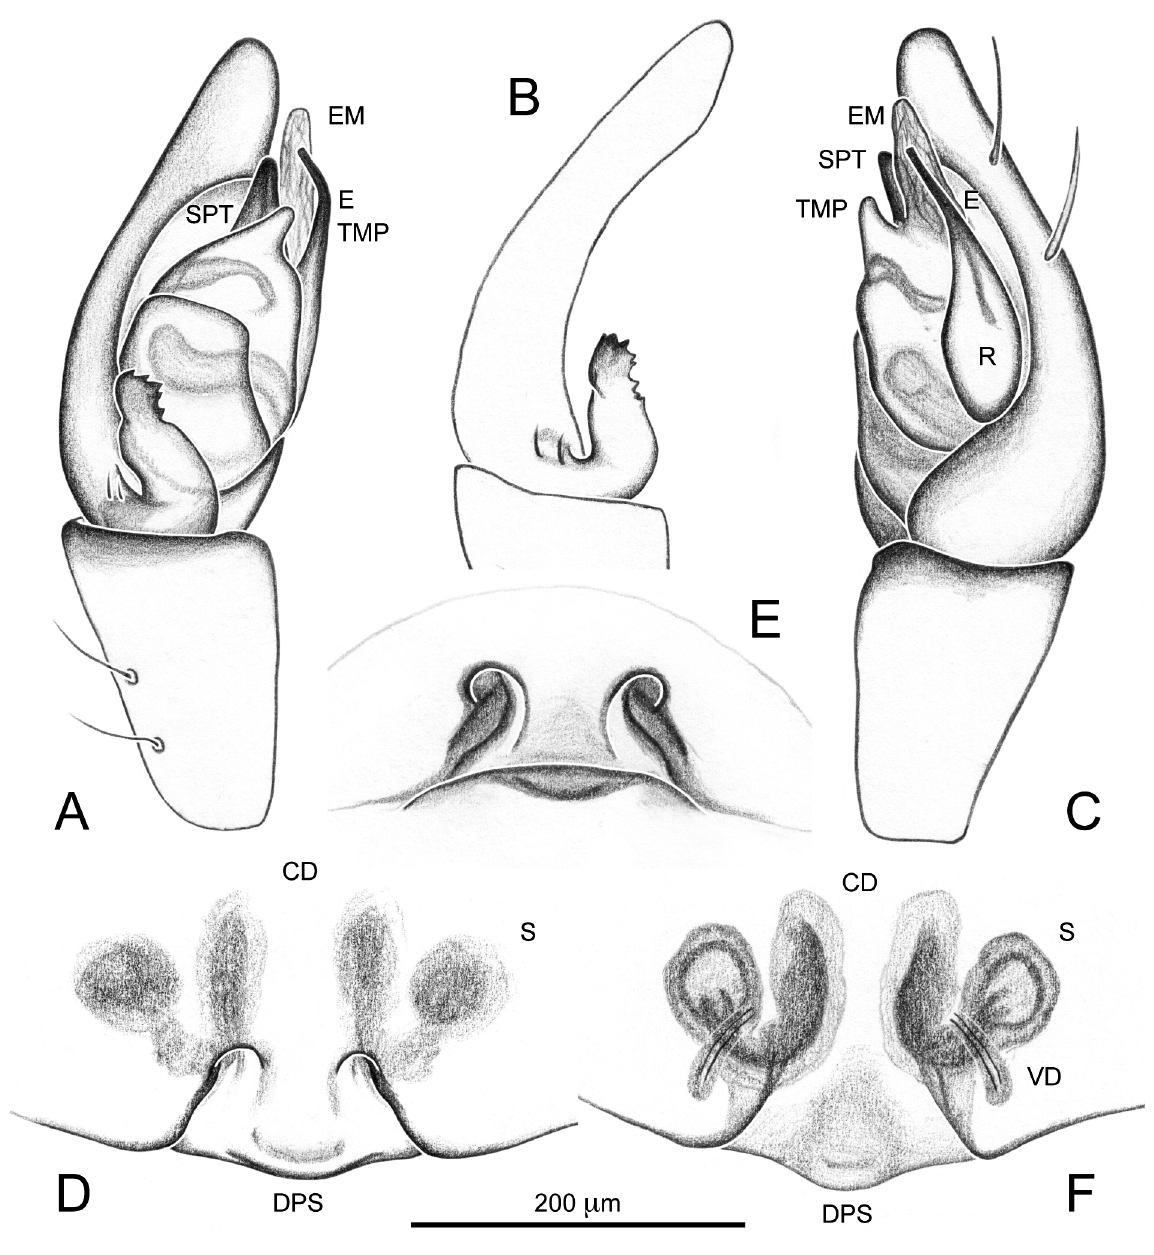
Fig. 9. Afroneta serrata sp. nov. A–C . Holotype, ♂ (UPSZMC 67569). A . Palp, retrolateral. B . Paracymbium, retrolateral. C . Prolateral. D–F . Allotype, ♀ (UPSZMC 67569). D . Epigyne, ventral. E . Aboral. F . Vulva,